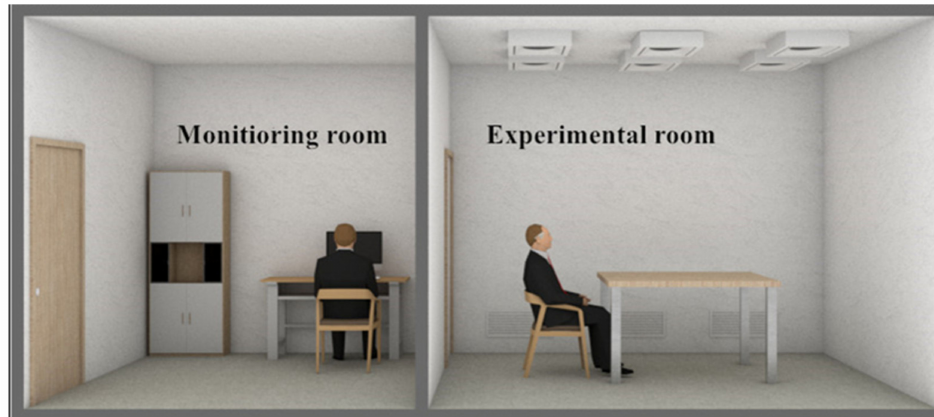
Figure 1. Layout of the artificial climate chamber.